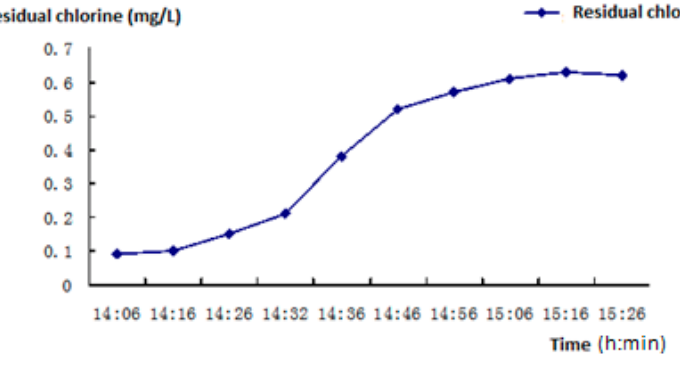
Figure 32. Data record of residual chlorine during the flushing process.